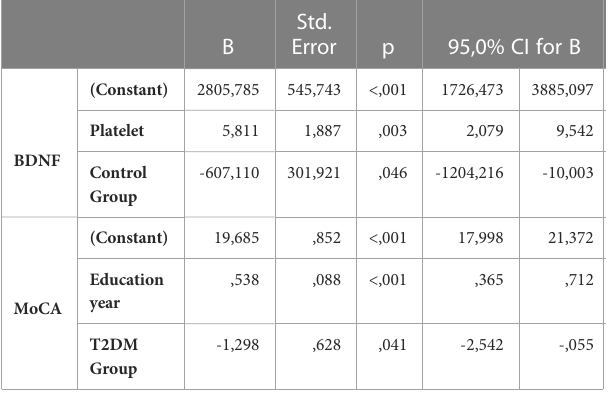
TABLE 3 Linear regression analysis for MoCA and BDNF